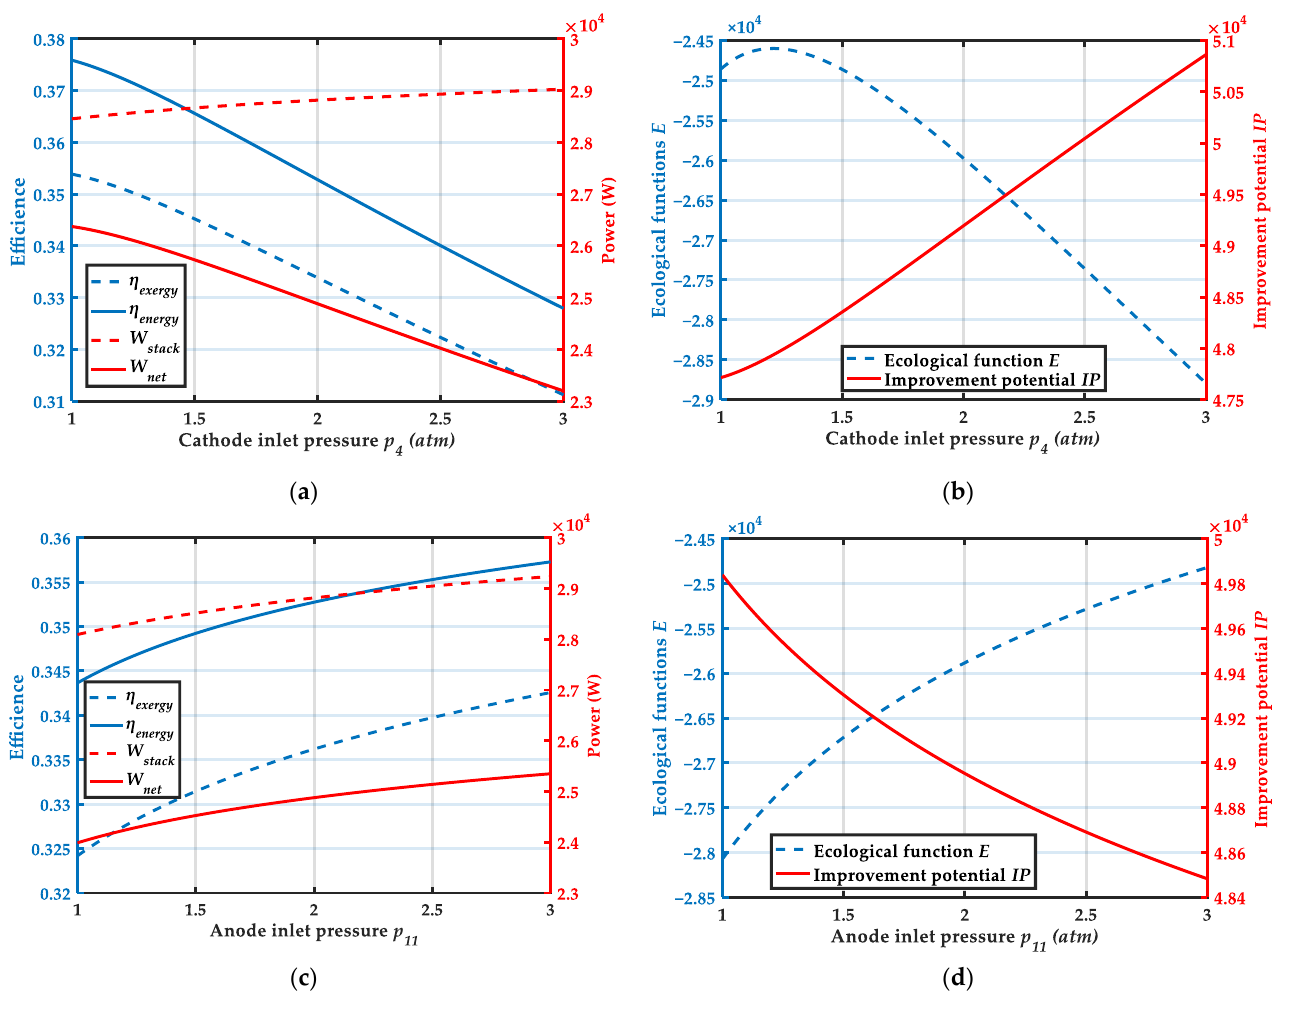
Figure 7. Variation trends of system performance with cathode and anode inlet pressures: ( a ) Vari- ation trends of 𝜂 𝑒𝑛𝑒𝑟𝑔𝑦 , 𝜂 𝑒𝑥𝑒𝑟𝑔𝑦 , 𝑊 𝑠𝑡𝑎𝑐𝑘 and 𝑊 𝑛𝑒𝑡 with cathode inlet pressures 𝑝 4 ; ( b ) Variation trends of ecological function 𝐸 and improvement potential 𝐼𝑃 with cathode inlet pressures 𝑝 4 . ( c ) Variation trends of 𝜂 𝑒𝑛𝑒𝑟𝑔𝑦 , 𝜂 𝑒𝑥𝑒𝑟𝑔𝑦 , 𝑊 𝑠𝑡𝑎𝑐𝑘 and 𝑊 𝑛𝑒𝑡 with anode inlet pressures 𝑝 11 ; ( d ) Variation trends of ecological function 𝐸 and improvement potential 𝐼𝑃 with anode inlet pressures 𝑝 11 .